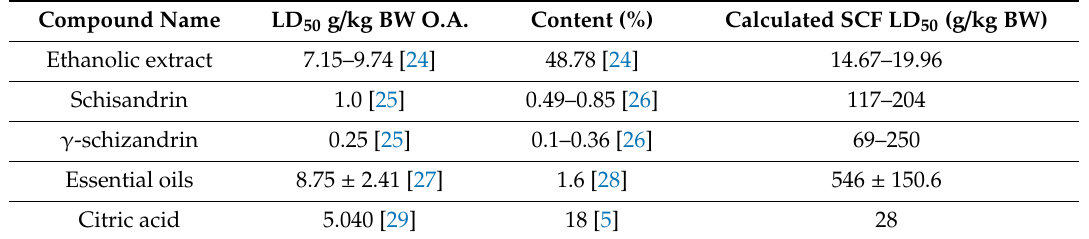
Table 3. The published LD 50 , the content (%) in S. chinensis , and the calculated LD 50 of the dried fruit (SCF) for various compounds and the ethanol extract. O. A., orally administered in mice.